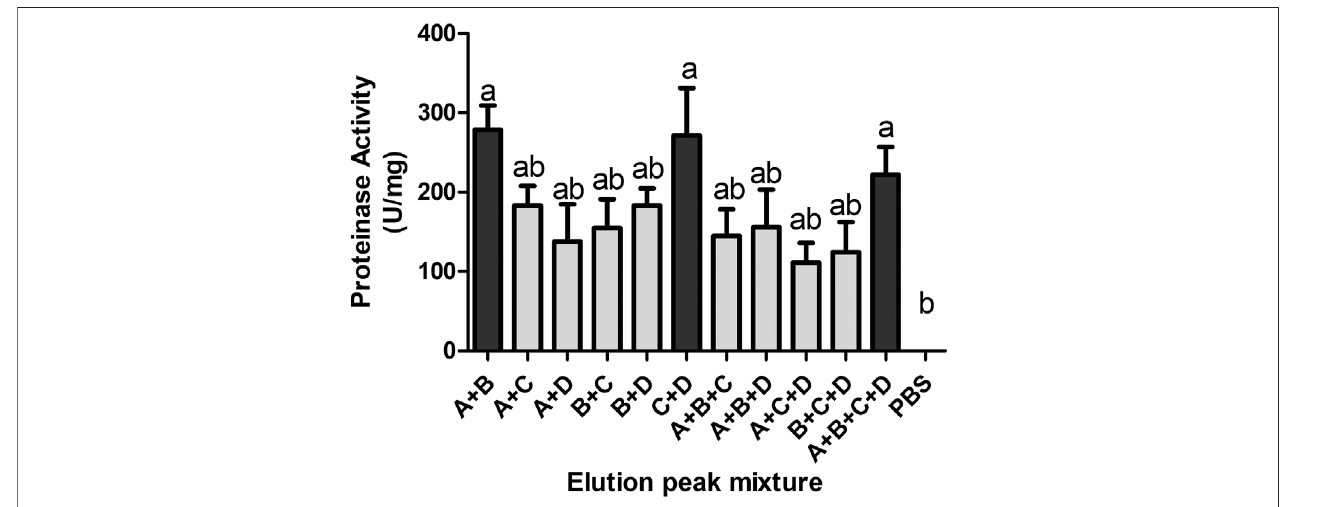
FIGURE 5 | Proteinase activity of different mixtures of the four elution peaks. Each group was an equal mixture of elution peaks in the same protein content. Three groups showed signi fi cant proteinase activity, p < 0.05.